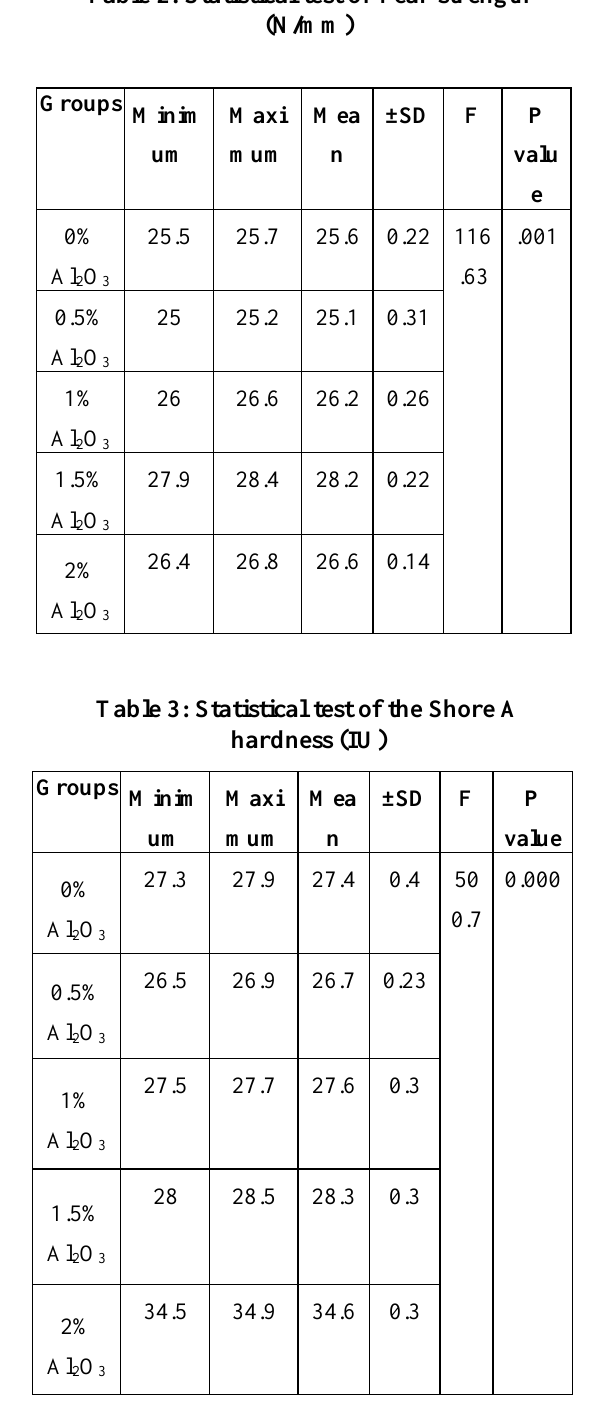
Table 2: Statistical test of Tear strength